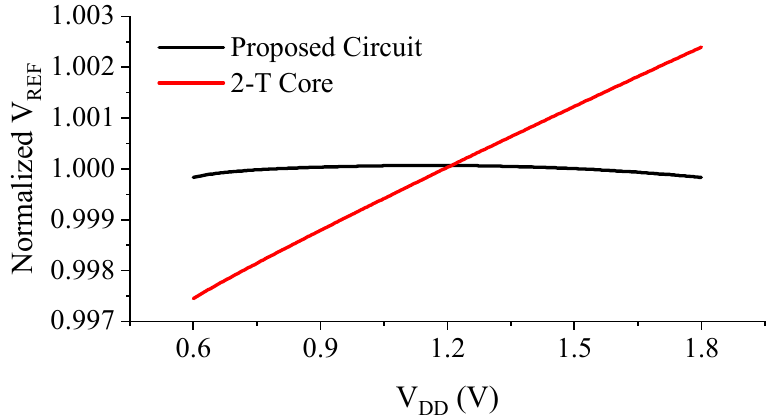
Figure 9. Normalized and magnified output voltages of the proposed design and the conventional 2-T reference.